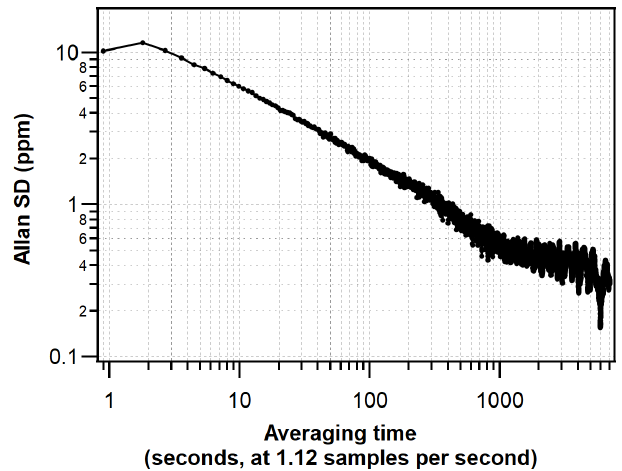
Figure 2. Allan deviation plot displaying the precision of the G2207- i O 2 mole fraction measured from an ambient compressed- air cylinder.